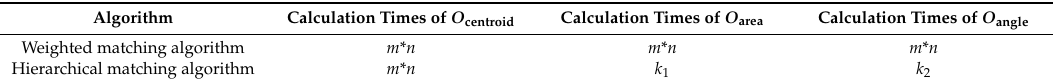
Table 1. Comparison of calculation times of sub-operators from two